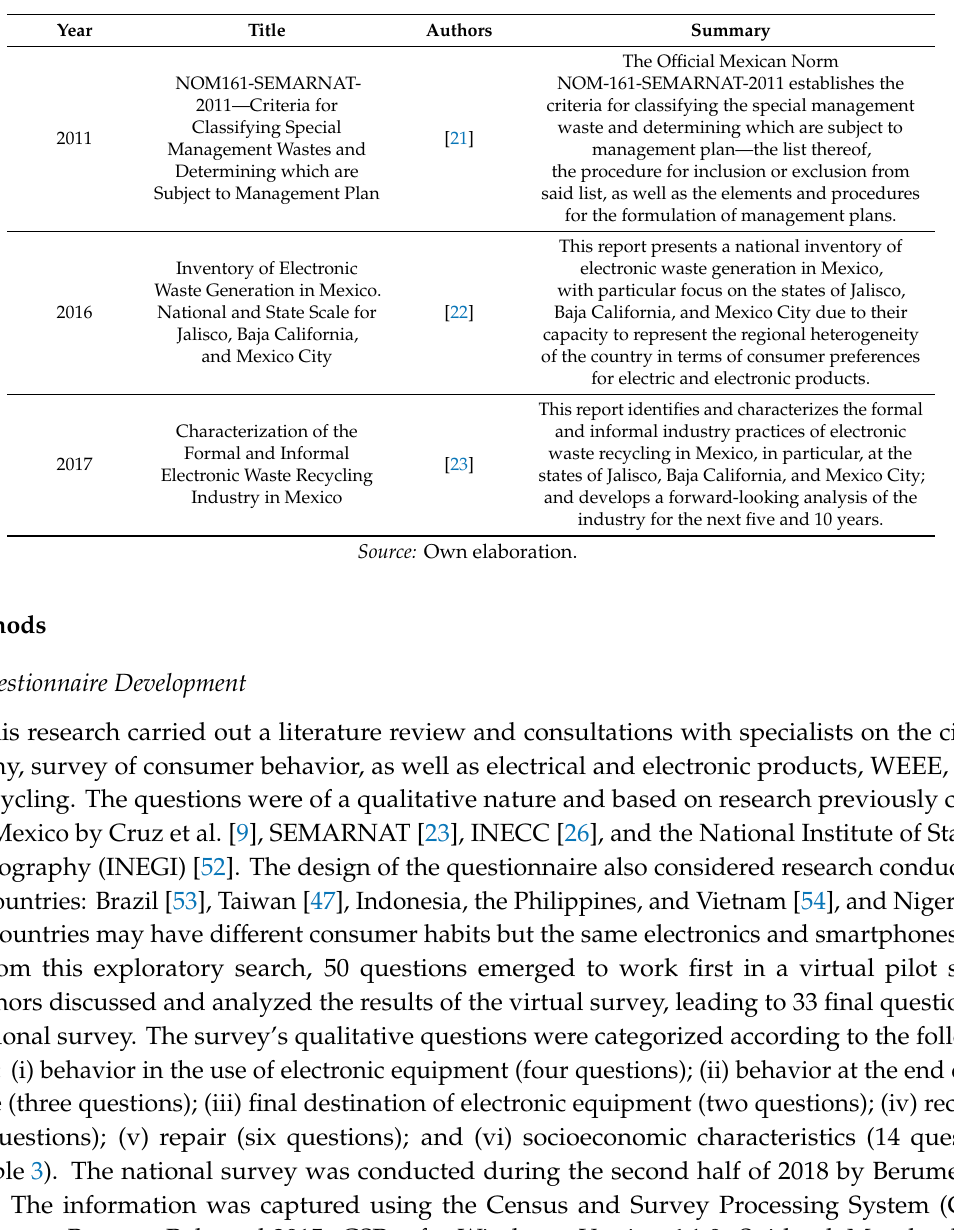
Table 2. SEMARNAT reports on electronic product consumers in Mexico.